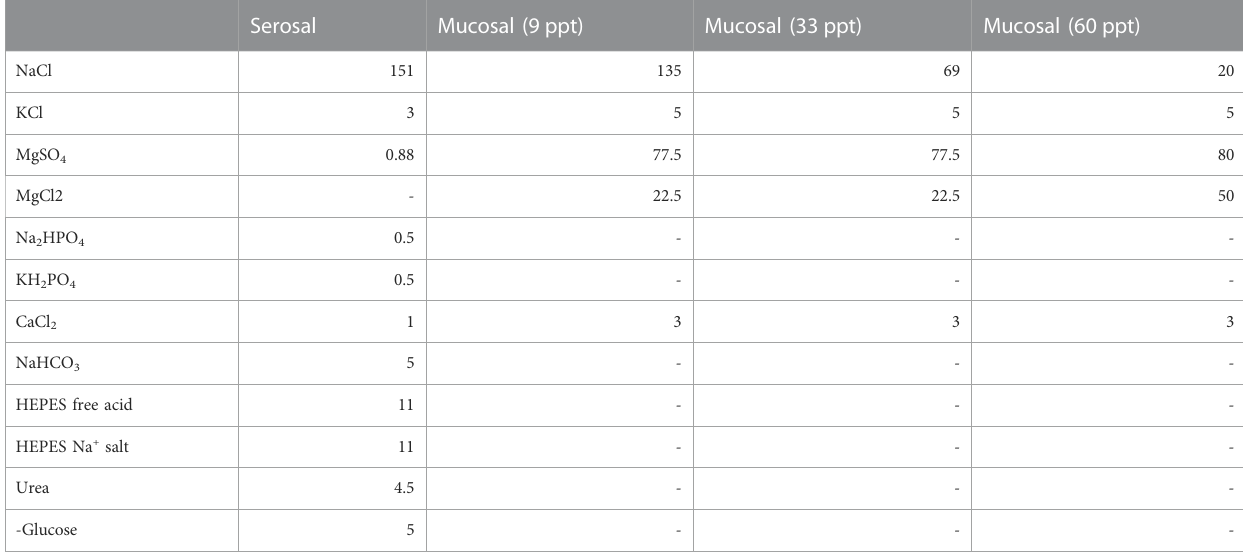
TABLE 2 Saline composition